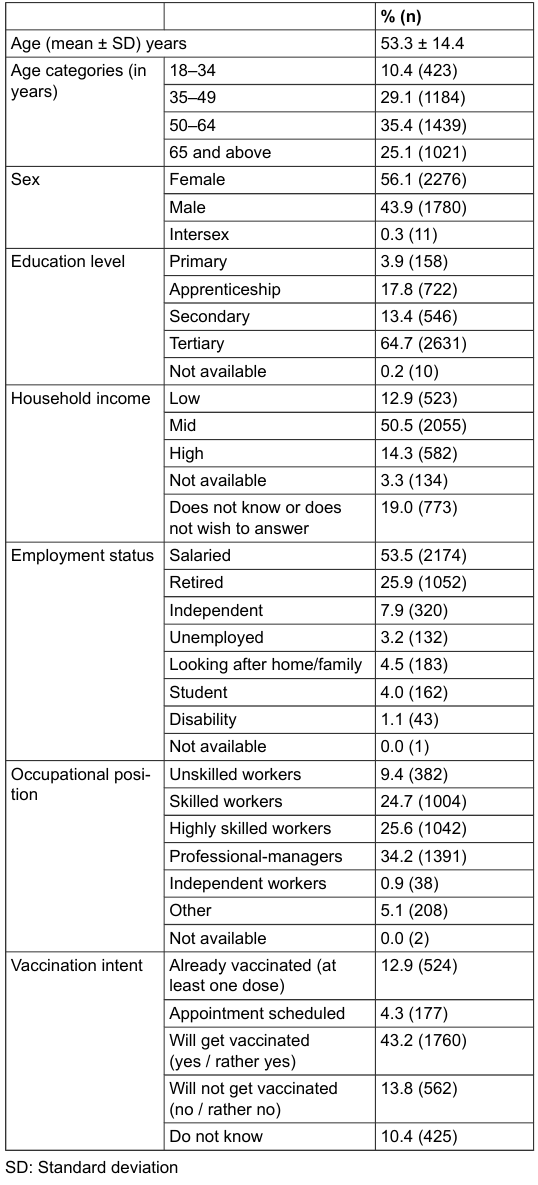
Table 1: Characteristics of participants (n =